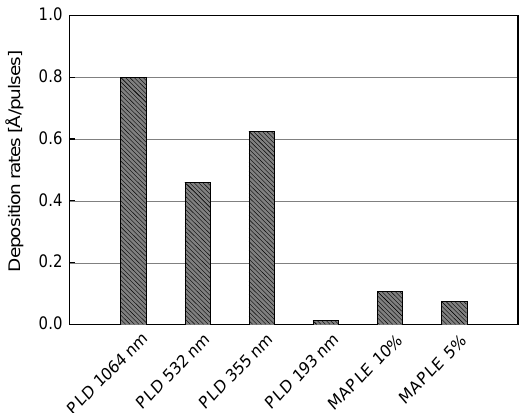
Figure 2. Kaolinite thin films deposition rates. Comparison between deposition methods: PLD and MAPLE.